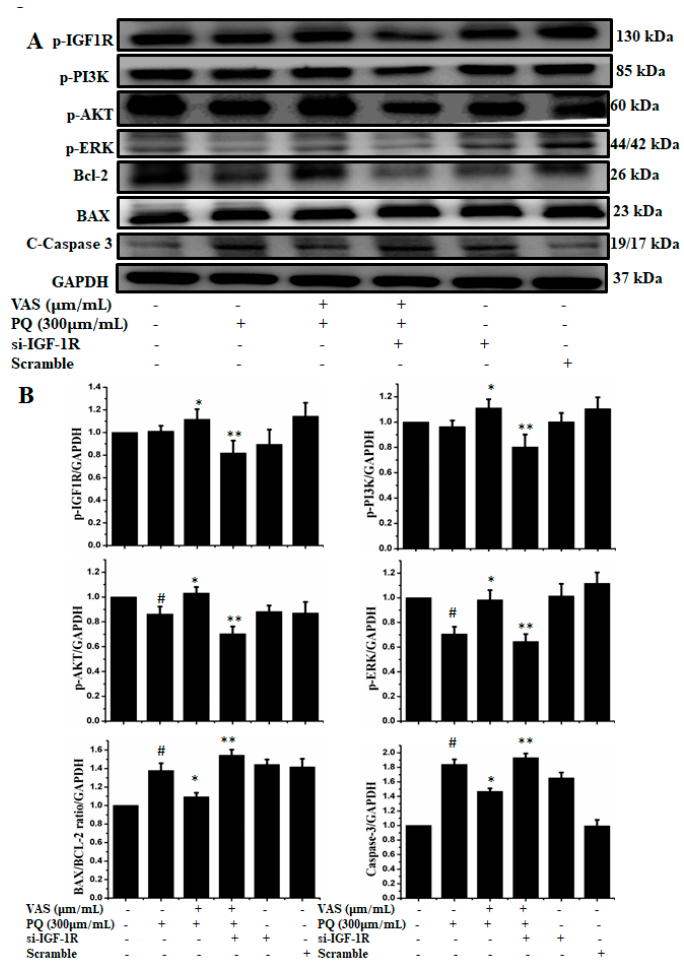
Figure 8. ( A ) Cells were transfected with 15 nM control siRNA (si Con) or IGF1R-targeted siRNA (si IGF1R) for 24 h, treated with 10 or 15 µ M vasicinone for 24 h and then exposed to paraquat (300 µ M) for an additional 24 h. GAPDH was used as an internal standard protein. ( B ) Expression of p-IGF-1R, p-PI3K, p-AKT, p-ERK, Bcl-2, apoptotic proteins Bax and caspase-3 were analyzed by densitometry of bands. Three independent experiments were performed. Results are shown as the